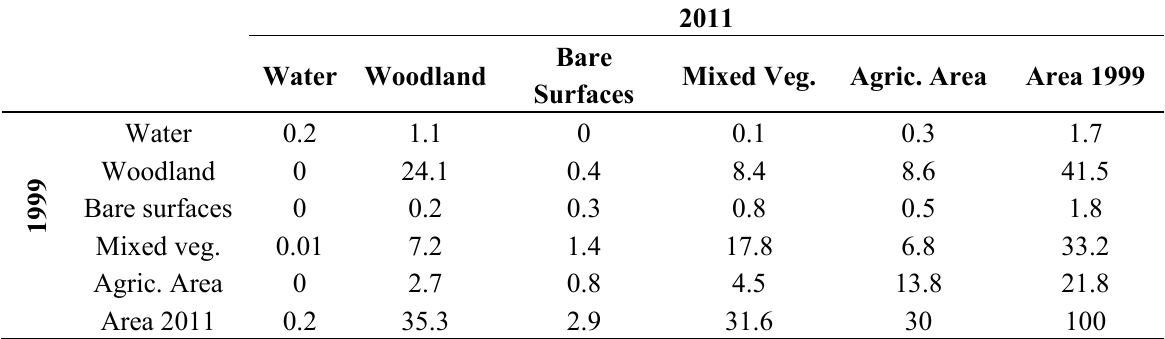
Table 20. LULC transfer matrix between 1999 and 2011 expressed as percentage of